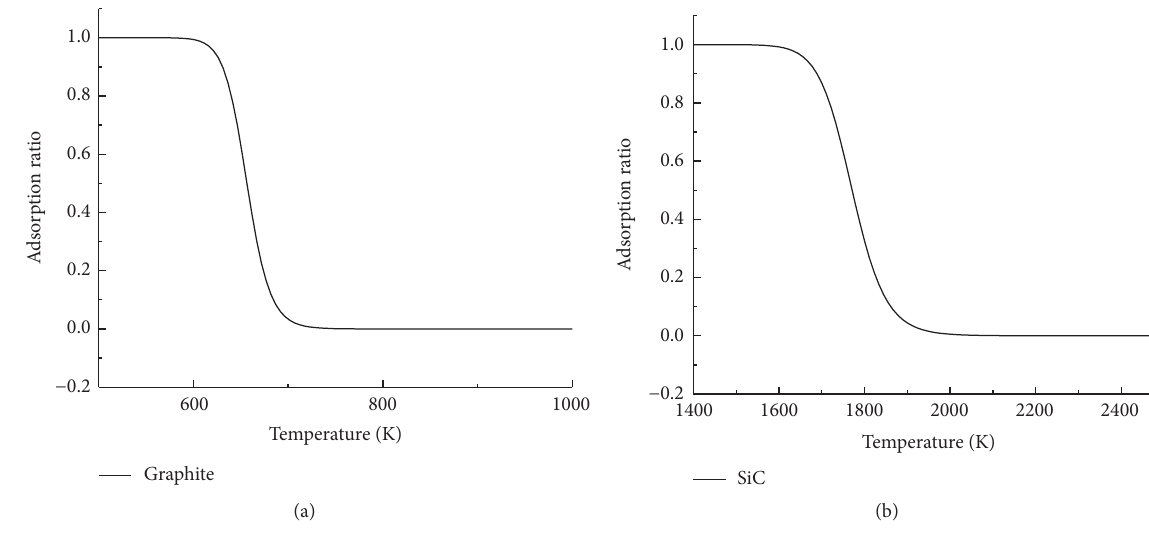
used for nuclear safety evaluation of Co release in the normal operation and the supposed accident of the